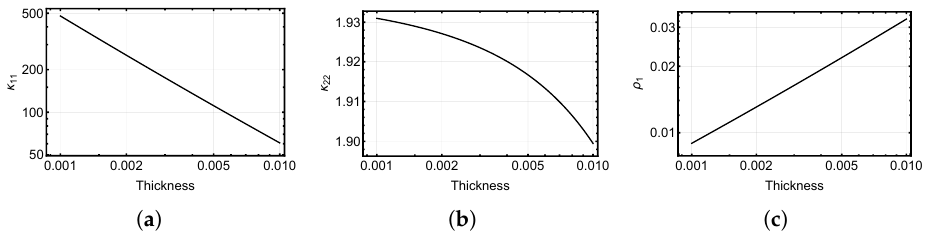
Figure 12. Clamped case. Practically perfect agreement with the a priori predictions. Notice, that κ 22 is essentially constant. Additionally, ρ 1 → 0 indicates that the Kirchhoff–Love condition is satisfied without imposing it within the model explicitly. ( a ) κ 11 ∼ 1/ t . ( b ) κ 22 ∼ 1. ( c ) ρ 1 ∼ t .